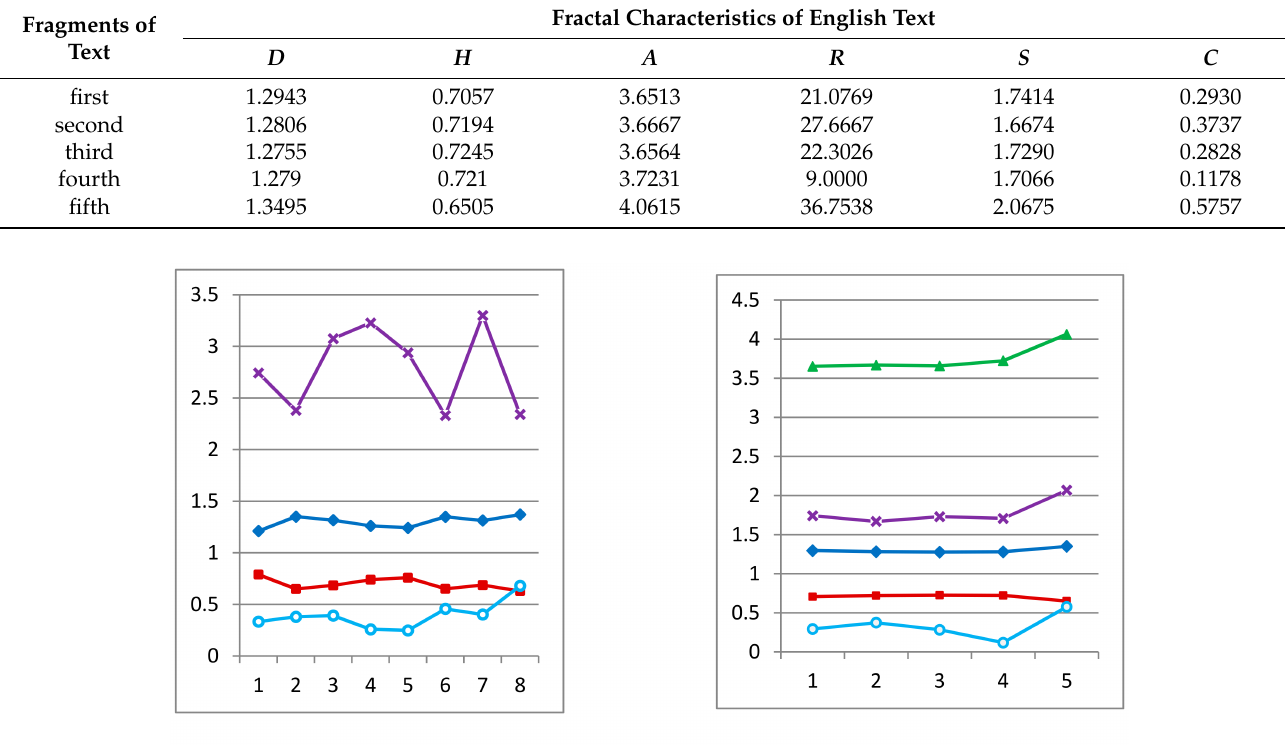
Table 4. Fractal characteristics of English text.